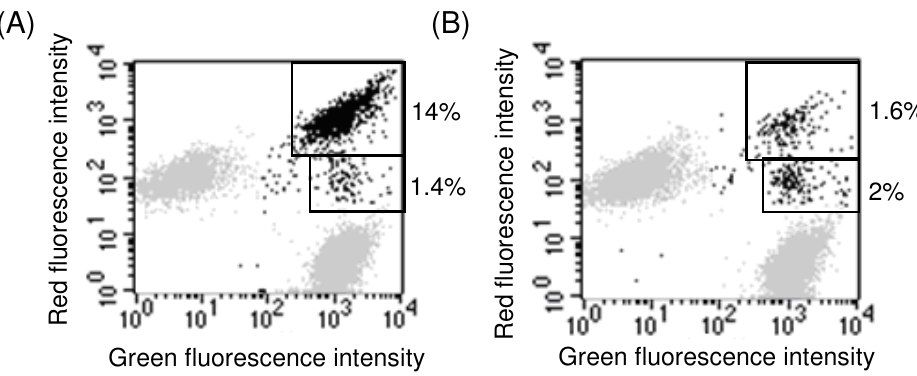
FIGURE 4 . Fluorescence profiles of FRET-positive (fused cells, upper region) and FRET-negative (cellular aggregates, lower region) particles in cocultures of DiI-CD4 + cells with (A) DiO-Env + cells and (B) DiO-Env + cells plus 30 µ g/ml anti-CD4 monoclonal antibody. (Adapted from Huerta et al.[87]. Copyright 2006, with permission from